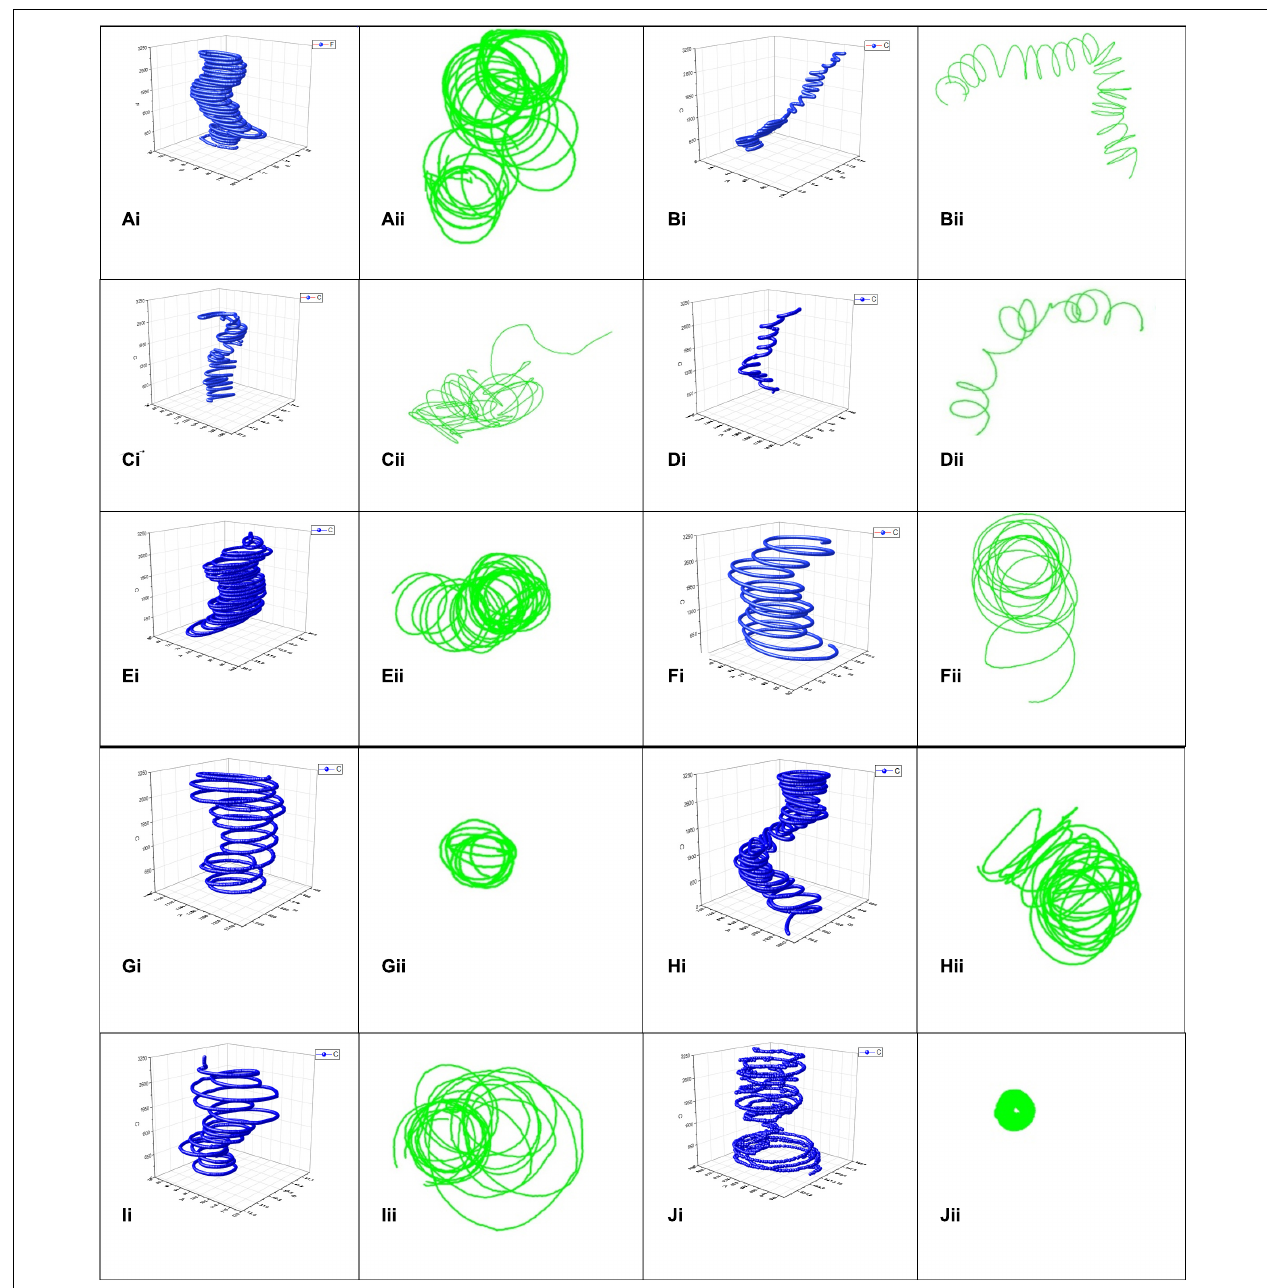
FIGURE 4 | Spongospora subterranea zoospore swimming trajectories analyzed in 3D (blue) and 2D (green) when zoospores were treated with deionized water control (Ai,Aii) , 100 µ M Amiloride (Bi,Bii) , 150 µ M Amiloride (Ci,Cii) , 200 µ M Amiloride (Di,Dii) , 100 µ M EGTA (Ei,Eii) , 500 µ M EGTA (Fi,Fii) , 1,000 µ M EGTA (Gi,Gii) , 2 µ M Trifluoperazine (Hi,Hii) , 3.5 µ M Trifluoperazine (Ii,Iii) , and 5 µ M Trifluoperazine (Ji,Jii) . Zoospore motility were tracked for 30 s with computer-vision tracking applications idTracker (blue) and ToxTrac (green), 10 min after acclimatizing in various Ca 2 + antagonist treatments or